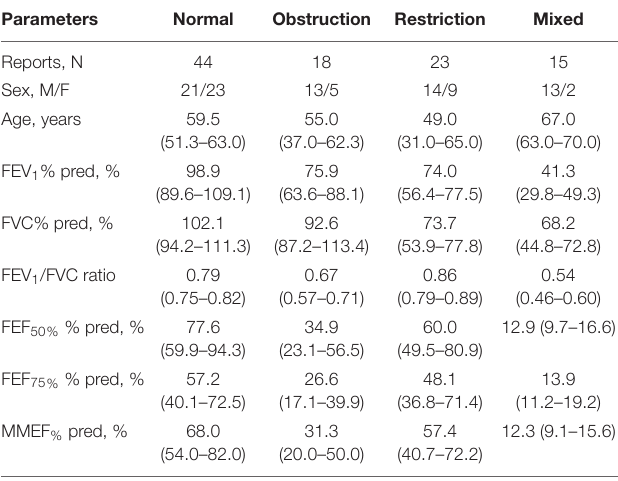
TABLE 2 | Characteristics of the 100 cases at study baseline.